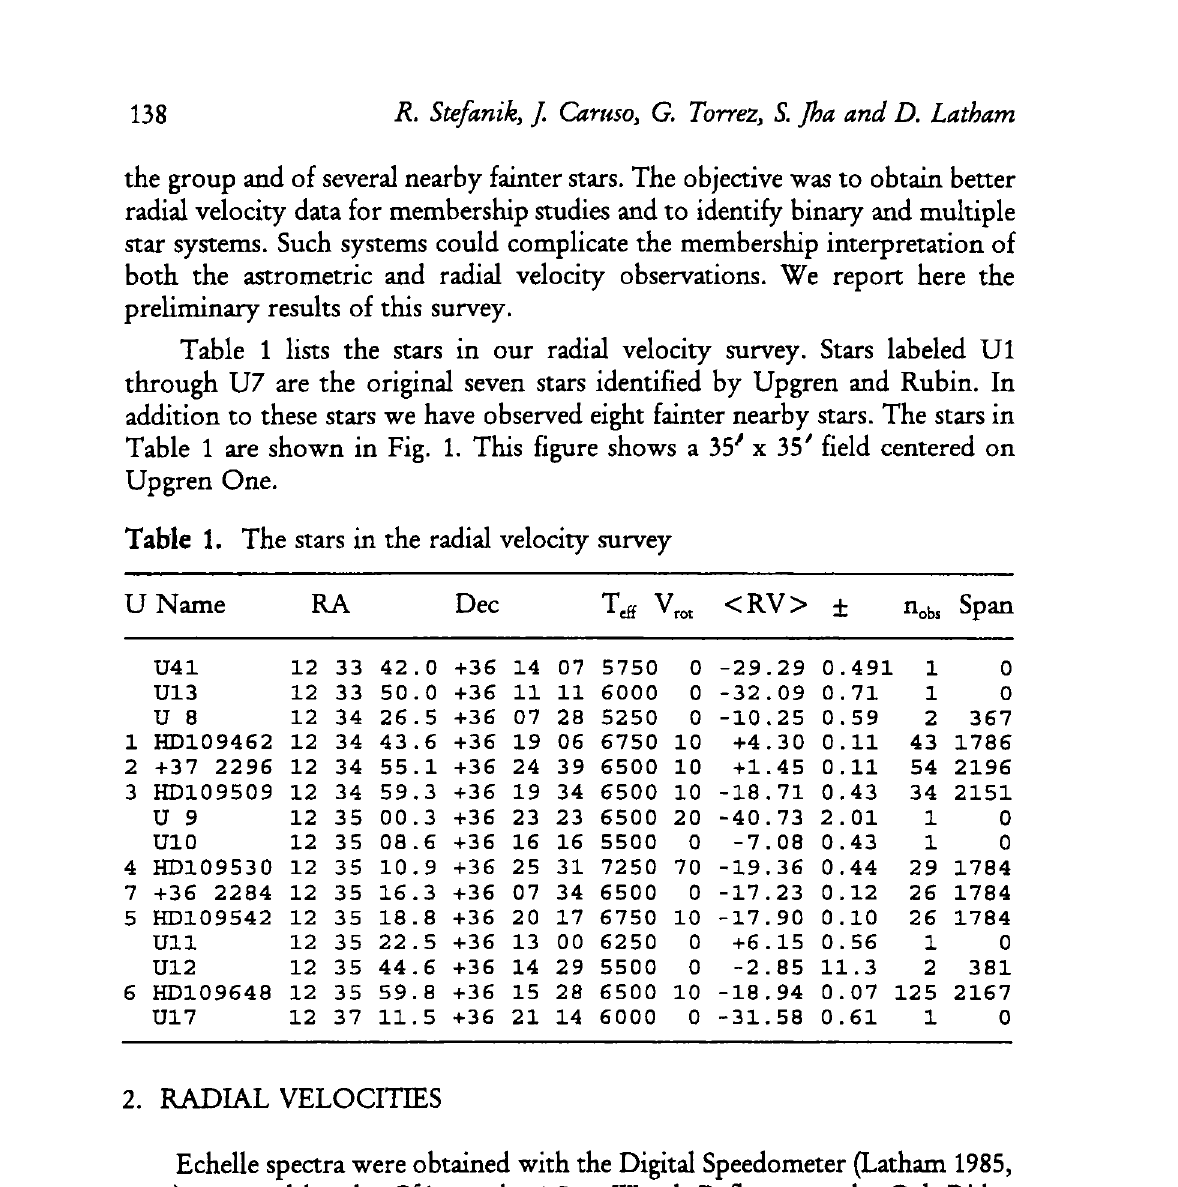
Table 1. The stars in the radial velocity